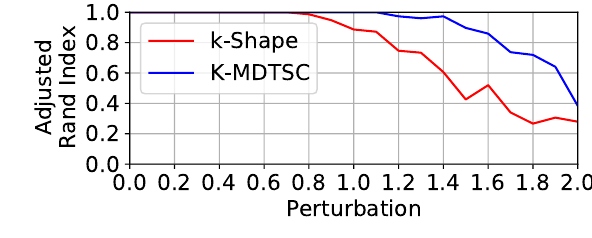
Figure 3. Perturbation